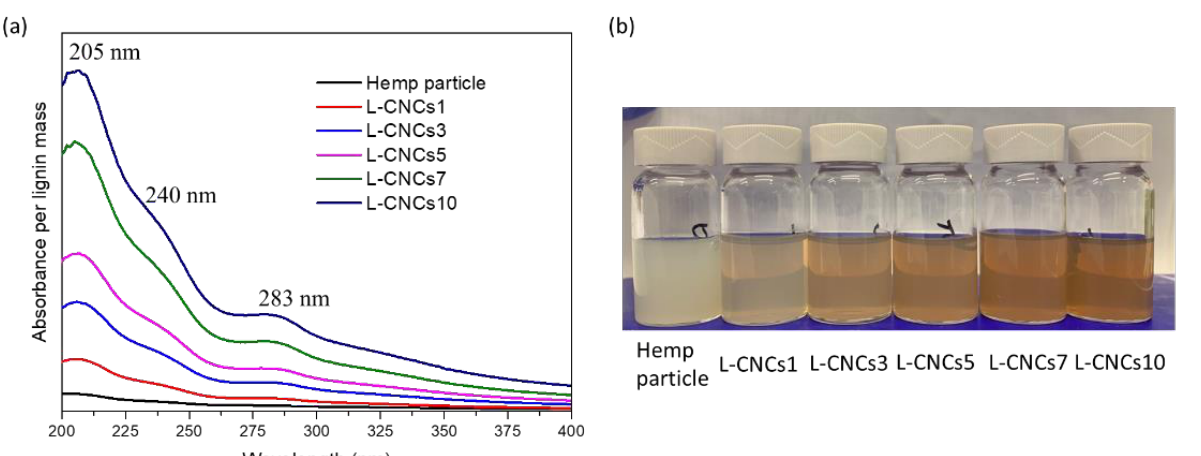
Figure 6. ( a ) UV – vis absorption (normalised per lignin mass in hemp particle and L-CNCs) and ( b ) digital image of hemp particle and L-CNCs.